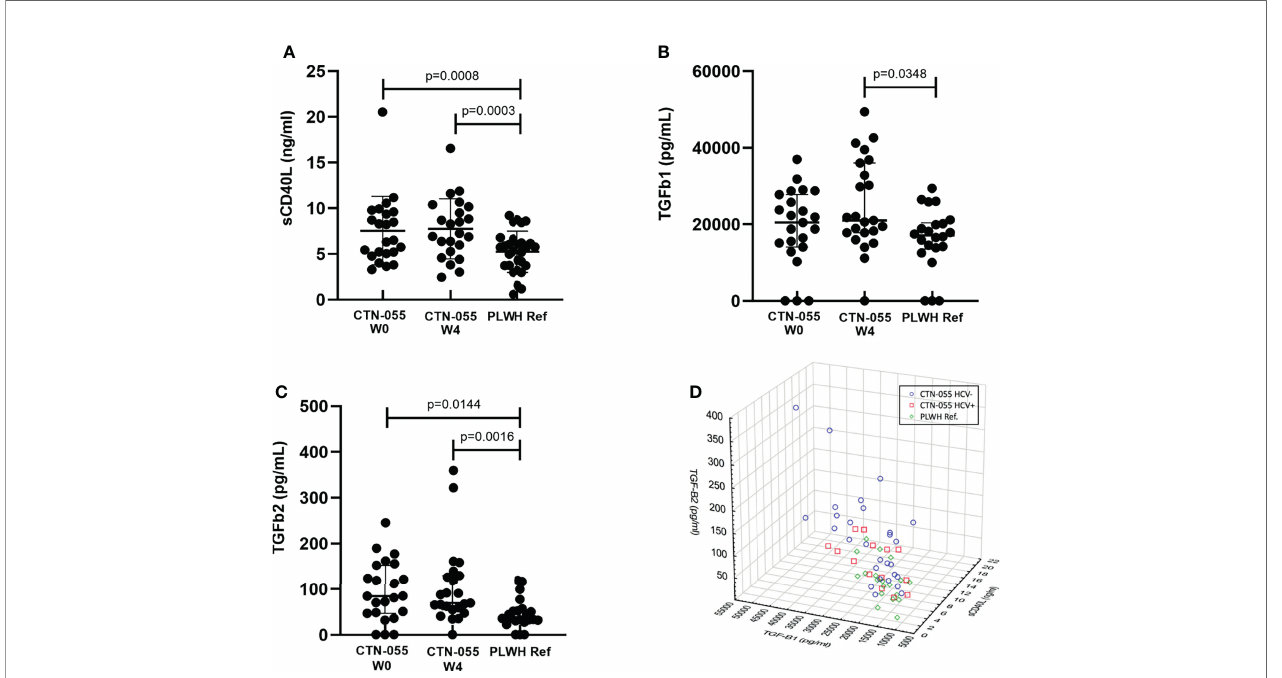
FIGURE 5 | Alcohol-use disorder Among PLWH is associated with an increased level of soluble CD40L, TGF- b 1 and TGF- b 2. Plasma levels of soluble CD40L (A) , and TGF- b 1 (B) and TGF- b 2 (C) were quanti fi ed by standard ELISA and cytokine U-PLEX assay, respectively, among CTN-055 participants at W0 (n = 23) and W4 (n = 23), and PLWH ref. population (n = 22) at study enrollment. Shown are means with SD (A) or medians with IQR (B, C) . When soluble CD40L, TGF- b 1, and TGF- b 2 were examined simultaneously, distinct clustering of study participants based on exposure to AUD and HCV was noted (D)